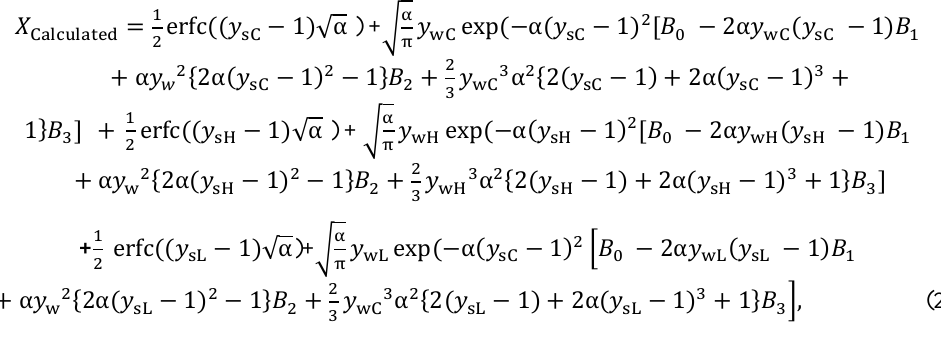
= 1 erfc((𝑦 − 1)√α ) + √ α sC 2